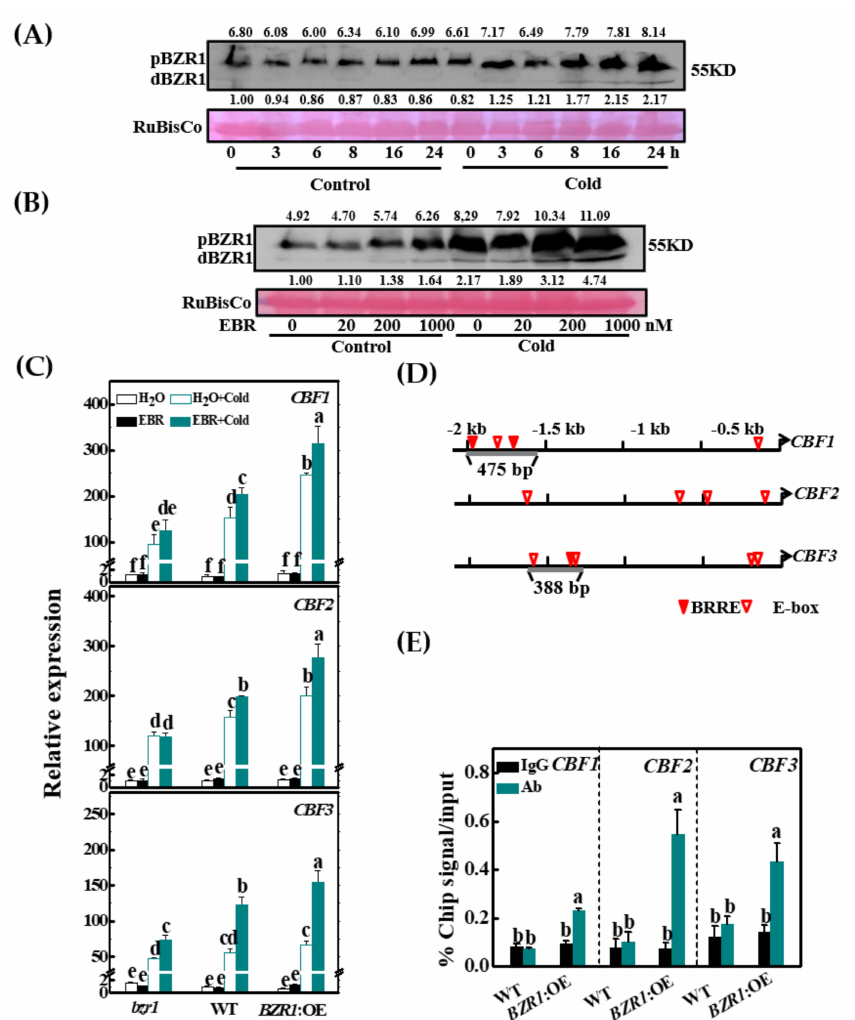
Figure 2. Cold-/BR-induced BZR1 functions as a transcription regulator for CBF expression. ( A ) The accumulation of BZR1 protein from tomato leaves exposed to 25 ◦ C (control) or 8 ◦ C (cold) for different periods of time. The values above and below each lane indicate the relative accumulation of pBZR1 and dBZR1, respectively. ( B ) The effect of 24-epibrassinolide (EBR) on the accumulation of BZR1 protein from tomato leaves under control and cold conditions. Plants were foliar applied with EBR at different concentrations for 24 h and subsequently exposed to cold at 8 ◦ C for another 12 h. In addition, 35S:BZR1 -3HA-overexpressing ( BZR1 :OE) plants were used for analysis for BZR1 protein. ( C ) The transcripts of CBFs in bzr1 mutant, wild-type (WT), and BZR1 :OE transgenic plants exposed to 25 or 8 ◦ C for 8 h; 24 h before cold treatment, the plants were foliar applied with 200 nM EBR or distilled water as the control. ( D ) BRRE and E-boxes in the tomato CBF promoter sequences. Numbering is from predicted transcriptional start sites. ( E ) ChIP-qPCR analysis of BZR1 binding to the promoters of CBF1 , CBF2, and CBF3 in tomato. Input chromatin was isolated from leaves exposed to 8 ◦ C for 8 h. CBF promoter fragments were immunoprecipitated with an anti-HA antibody. Mouse IgG was used in control reactions. Input- and ChIP-DNA samples were quantified by qRT-PCR. The ChIP data are shown as % input DNA. Data are the means of three biological replicates ( ± SD) shown by vertical error bars. Different letters indicate significant differences according to Tukey’s test at 0.05%